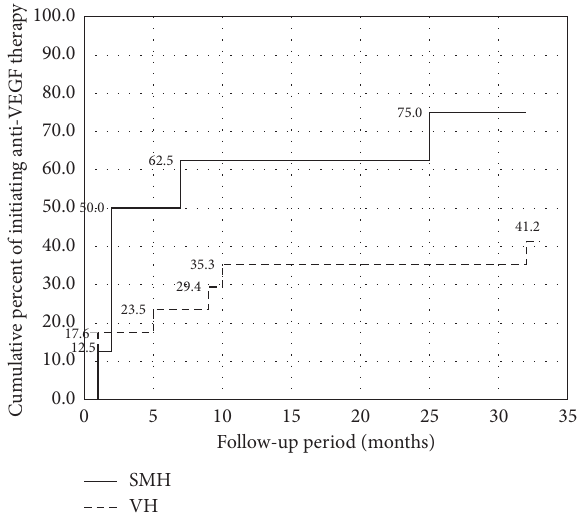
Figure 3: Cumulative percent of anti-VEGF therapy